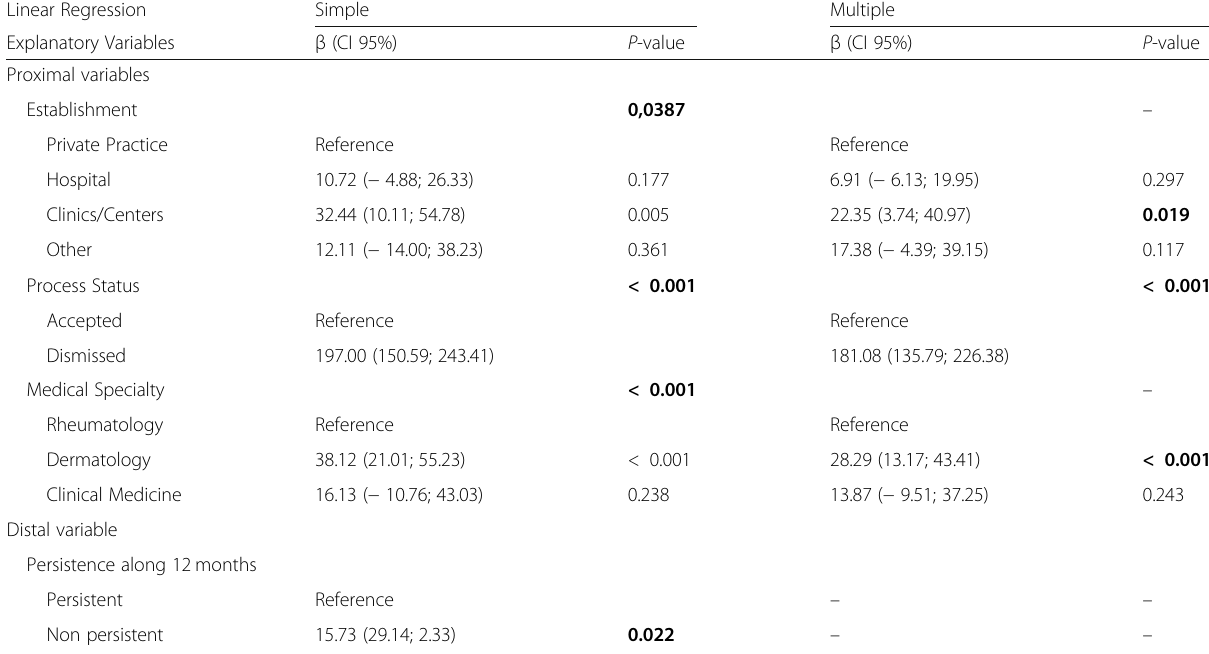
Proximal variable=cross-sectional variables, collected in the administrative processes Distal variables=longitudinal variable, collected after 12months in the information systems Bold: p -value